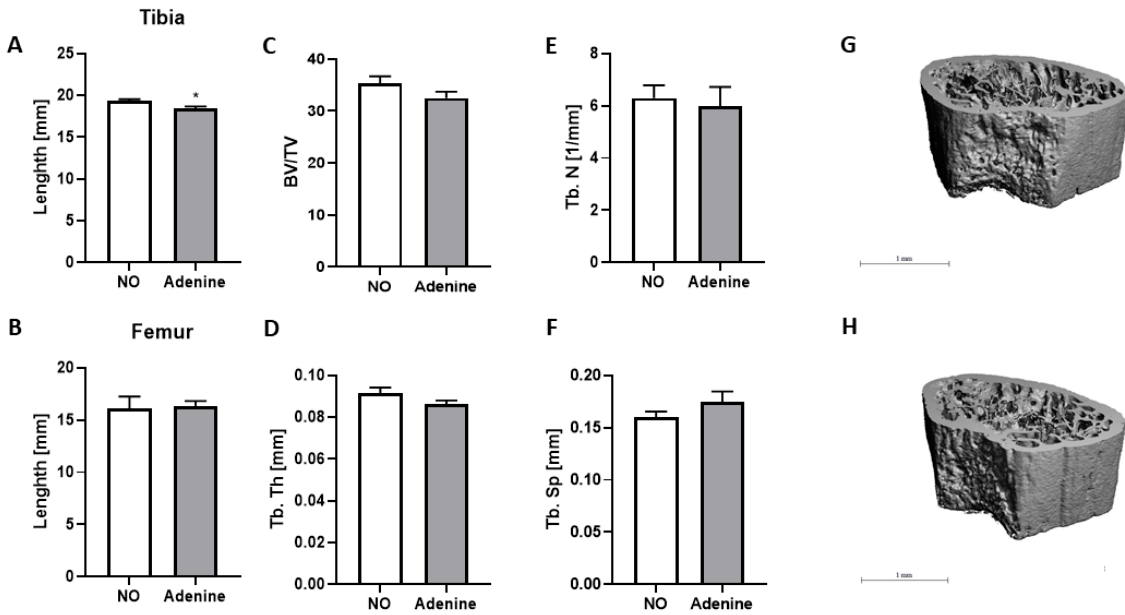
Figure 6. Bone analyses in 12 weeks old ApoE KO mice with normal renal function or adenine-induced nephropathy. ( A ) Length of tibias and ( B ) femurs were measured with a caliper. The distal part of the femurs was analyzed by µ CT scan and computer-aided analysis: ( C ) bone volume (BV/TV), ( D ) trabecular thickness (Tb. Th), ( E ) trabecular number (Tb. N), and ( F ) trabecular space (Tb, Sp) are shown. Representative 3D lCT images of the femur from a mouse ( G ) with a normal kidney and ( H ) adenine-induced nephropathy. Scale bar = 1mm. NO represents the control group fed with WD-CAC. Data are shown as mean ± SEM ( n = 8–9). For statistical significance, * p < 0.05.